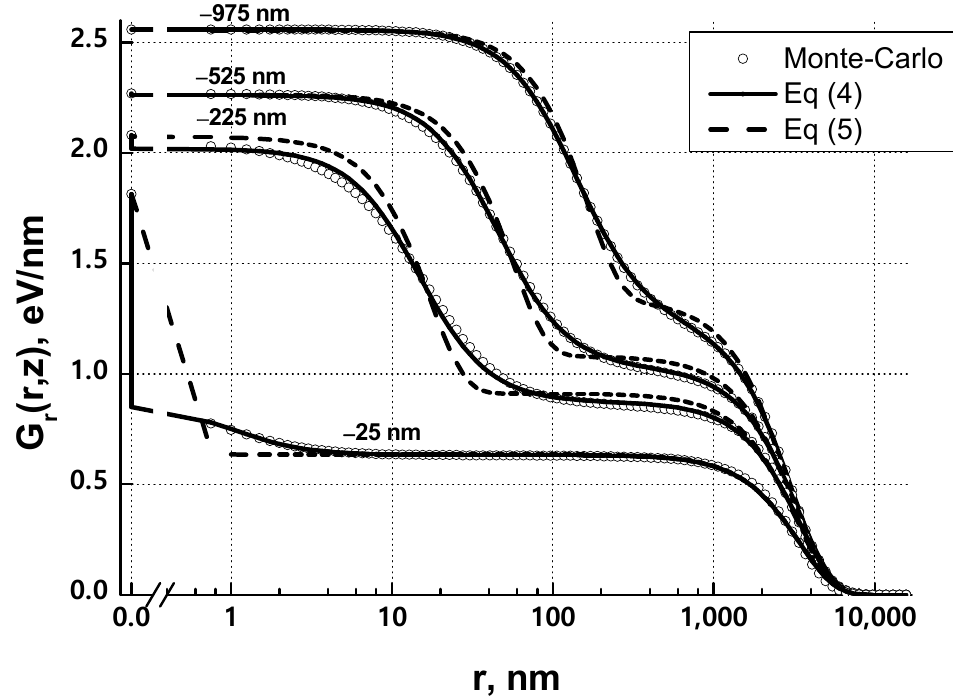
Figure 2. The results of fitting the integral density of the absorbed energy, calculated by the Monte Carlo method, by two different functions (4) and (5) for four cross sections in z : − 25 nm, − 225 nm, − 525 nm and − 975 nm. The resist film thickness (PMMA) is 1 micron. The substrate is Si (300 µ m). The initial energy of electrons is 25 keV. The number of trajectories considered is 200,000.